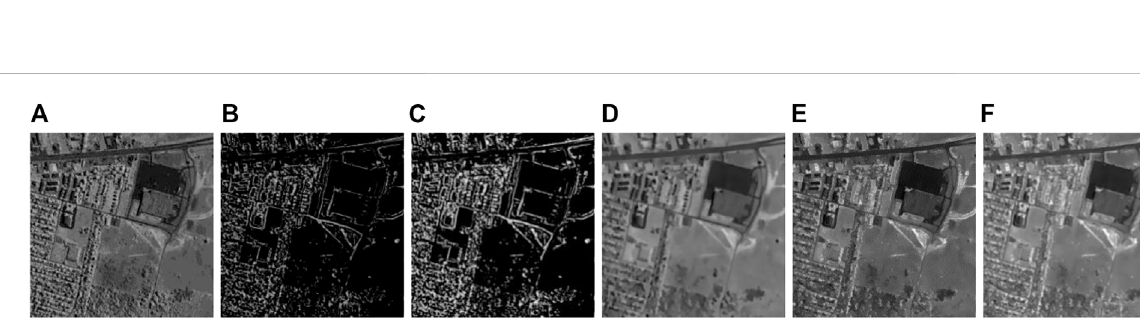
FIGURE 3 Comparison of the denoising results with TV regularization and PC regularization. (A) Noisy image from HYDICE urban HSI data, (B) Gradient magnitudemaps, (C) PCfeaturemaps, (D) RestoredbythemodelwithTVregularization[PSNR:33.58dB;SSIM:0.9345], (E) Restoredbythemodelwith PC regularization [PSNR:33.41dB; SSIM:0.9541] (F) Restored by the model with hybrid smoothness regularization combining TV and PC [PSNR: 34.27dB;